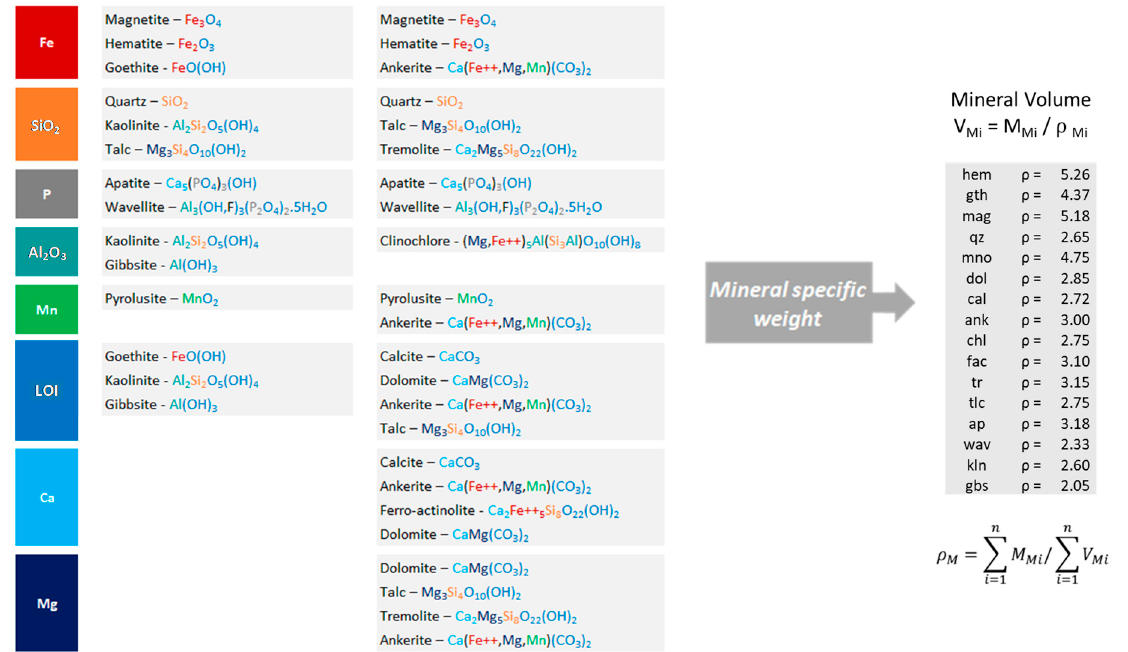
Figure 2. Illustration of how the chemical composition of the samples was allocated to the different minerals for weathered (left column) and unweathered (right column) materials. The density assumed for each mineral in the Mineral Norm algorithm (MNC) is shown on the right of the figure. V Mi = mineral volume, M M i = mineral mass, ρ Mi = mineral density.